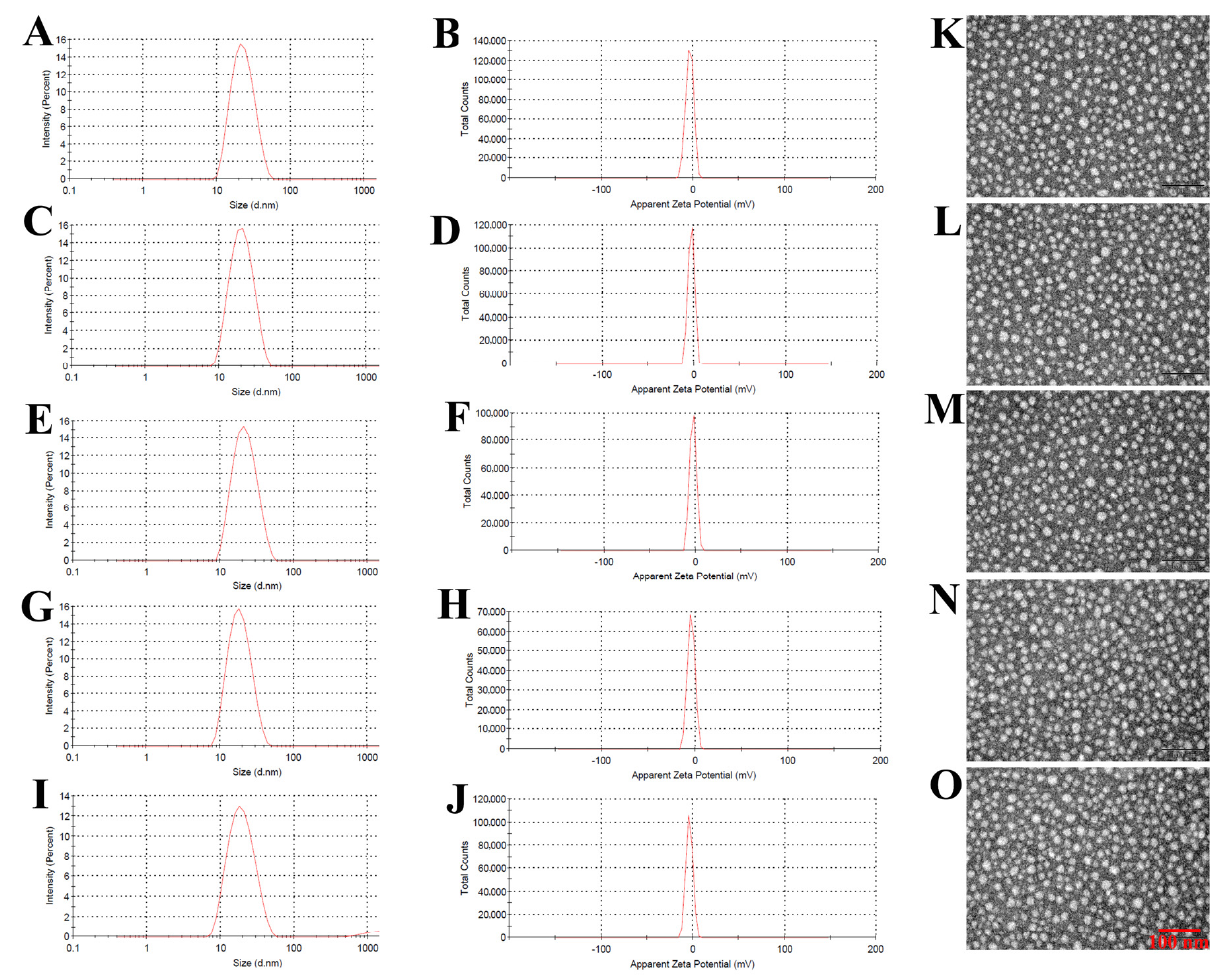
Figure 1. The size and morphology of the formulations: ( A – J ) are particle size distribution and zeta potential of GA/PTX- NLC, dNP2-GA/PTX-NLC, FA-GA/PTX-NLC, FA/dNP2-GA/PTX-NLC, and cFA/dNP2-GA/PTX-NLC; as determined by dynamic light scattering. ( K – O ) represents the TEM images of them, respectively (scale bar = 100